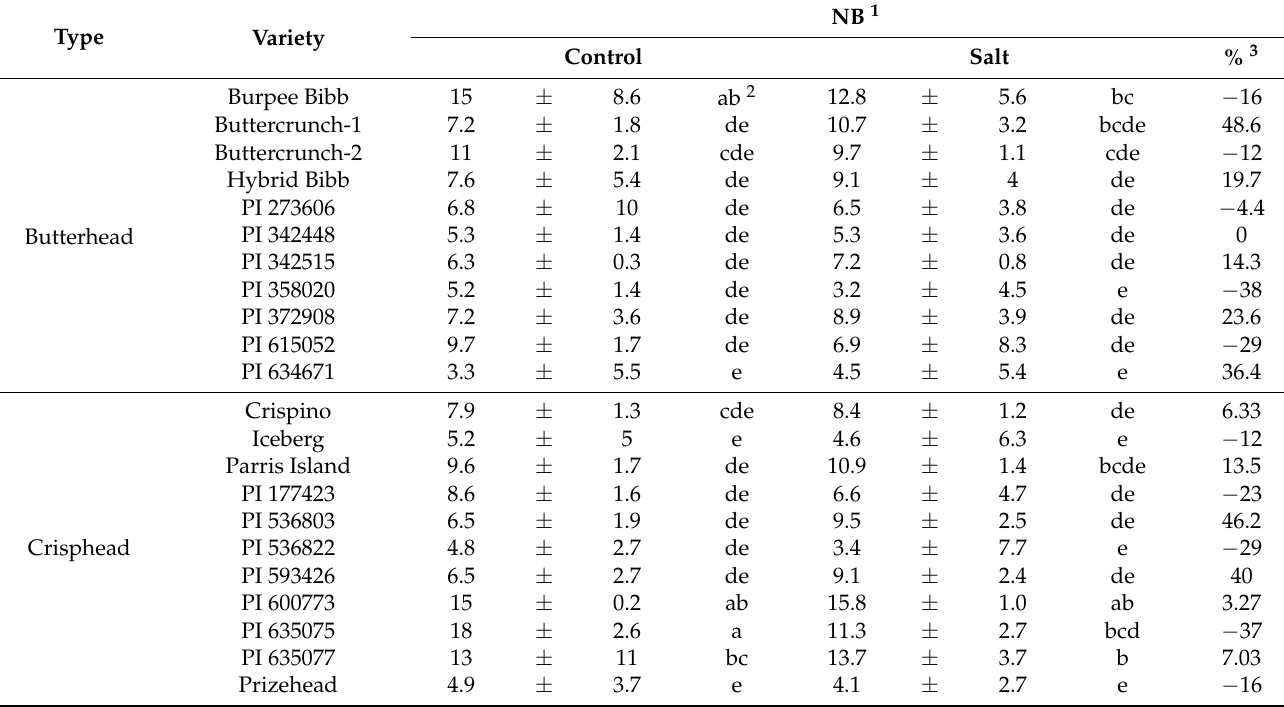
Table 11. Nitrogen balance index (NB (mean ± standard deviation, n = 4) of butterhead- and crisphead-type lettuce cultivars grown under control and salt-stress conditions (100 mM) after 42 days of sowing (10 days after salt treatment). Type